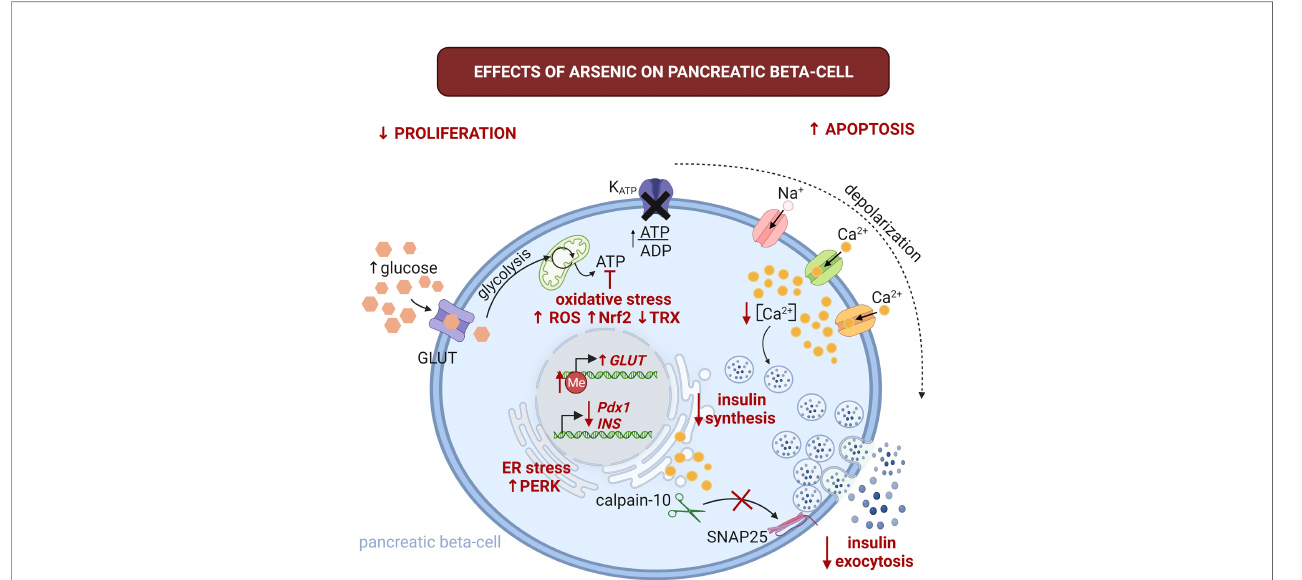
FIGURE 1 | Effects of arsenic on pancreatic beta-cell physiology. The alterations induced by this pollutant are highlighted with red font. Arsenic could promote glucose intolerance and T2D through beta-cell damage and impaired GSIS. It promotes beta cell apoptosis, while inhibiting proliferation. This can lead to imbalance in beta-cell mass contributing to decreased insulin secretion and promoting the development of T2D. Arsenic severely impairs glucose tolerance by the reduction of GSIS. It affects insulin synthesis by decreasing insulin mRNA (INS) levels, increasing endoplasmic reticulum (ER) stress and activation of protein kinase RNA-like endoplasmic reticulum kinase (PERK). Arsenic can also impair GSIS through several mechanisms, including oxidative stress by altering mitochondrial metabolism, this can also lead to alterations in the ATP/ADP ratio, which is an essential step for GSIS. Arsenic inhibits the oscillations of intracellular Ca 2+ and reduces the proteolysis of synaptosomal-associated protein 25kDa (SNAP-25) by calpain-10 protease. These alterations result in decreased insulin secretion. GLUT, glucose transporter (GLUT1 and 3 in humans, GLUT2 in rodents); Me, 5-methylcytidine; Nrf2, nuclear factor erythroid 2-related factor 2; Pdx1, pancreatic and duodenal homeobox 1; ROS, reactive oxygen species; TRX, thioredoxin. Created with